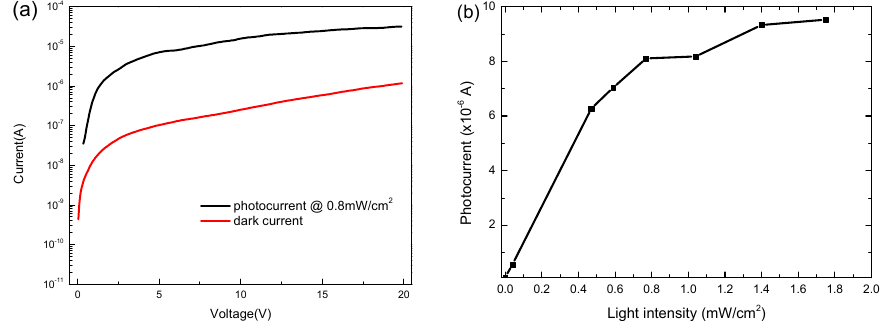
Figure 11. ( a ) Current–Voltage (I–V) characteristics and ( b ) dynamic range of the MSM-MAPbBr3 crystal photodetector under illumination of 0.8 mW/cm 2 and measured at 5 V.